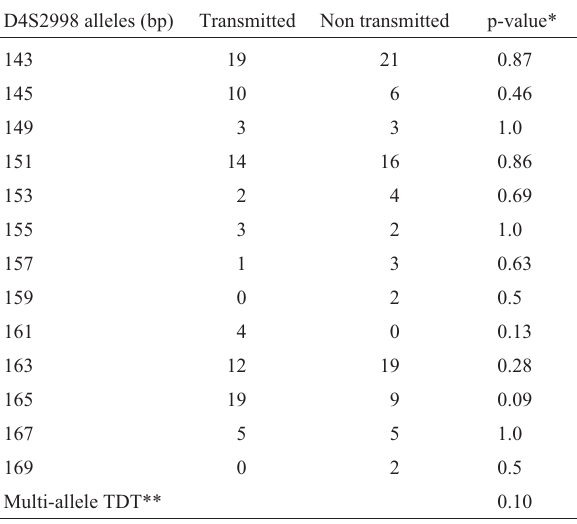
*Statistical significance for individual alleles was assessed using exact p-values. **Multi-allele TDT p-value based on simulations was computed as